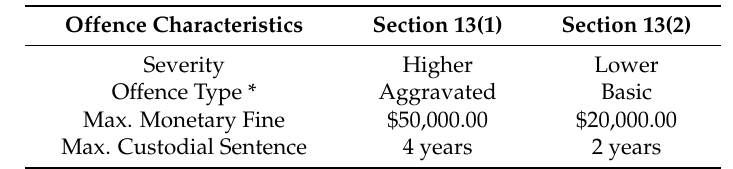
Table 1. Differences between the two animal welfare charges under section 13 in the Animal Welfare Act 1985 (SA)